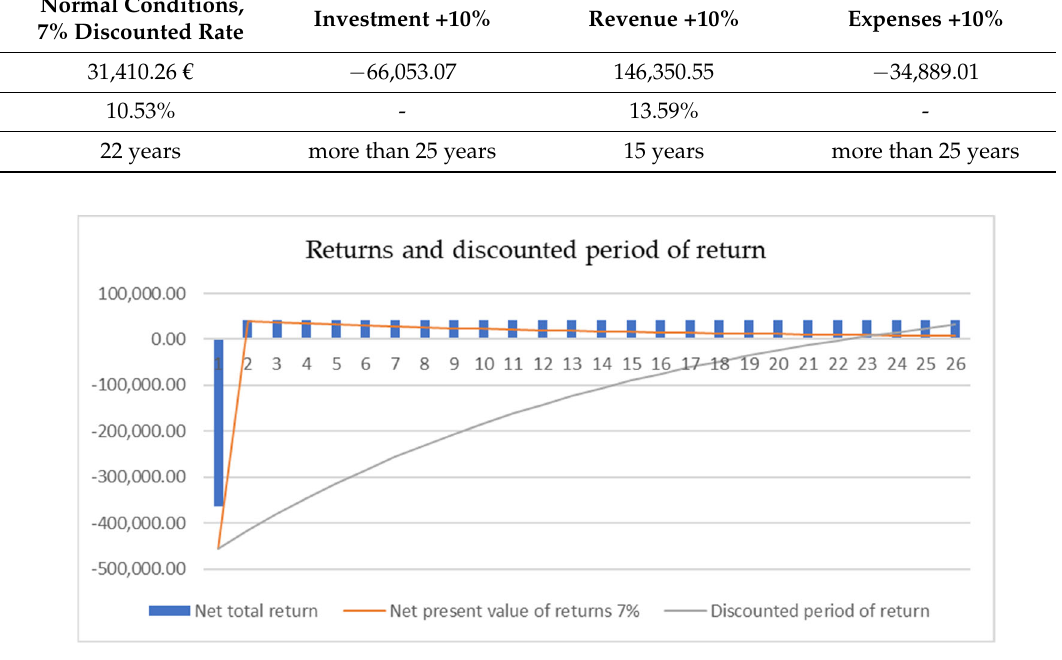
Figure 8. Economic indicators of location Naklo 1.